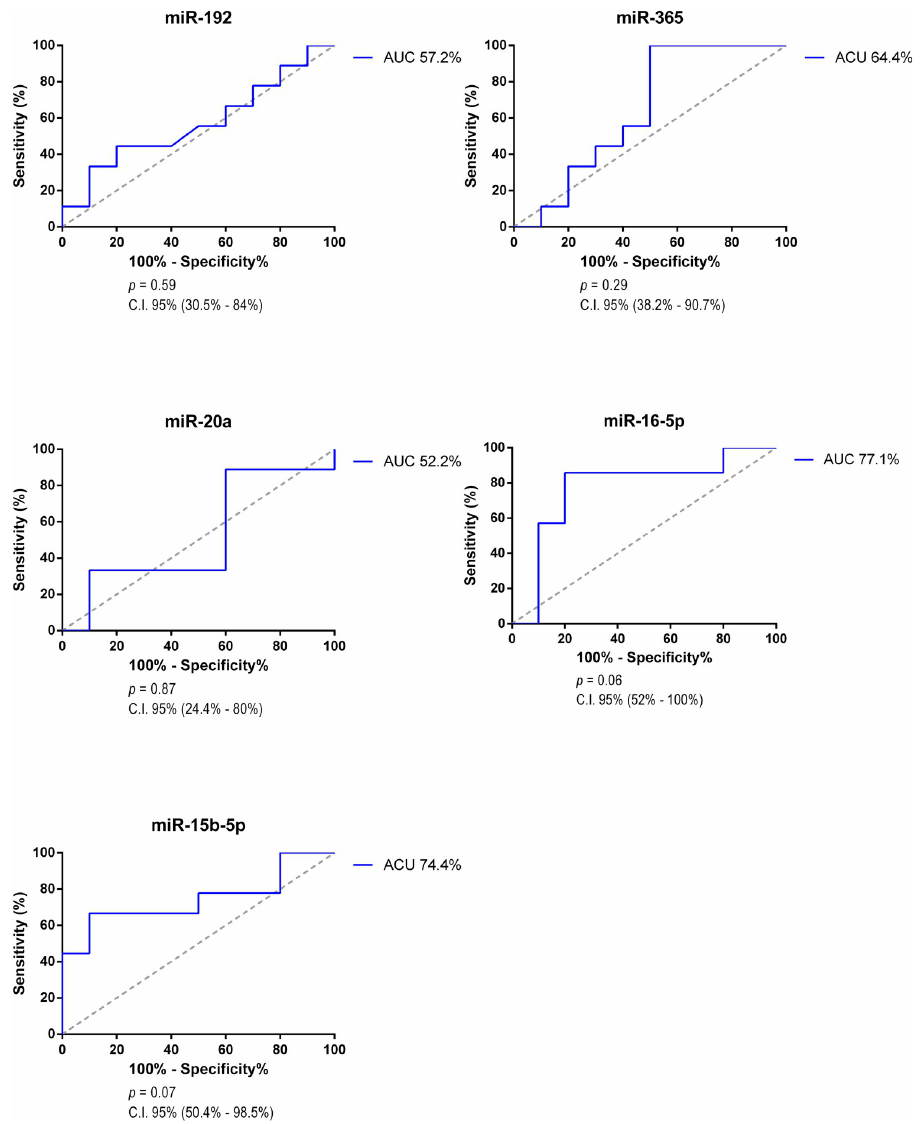
Fig 3. ROC curve of plasma microRNAs (Control x